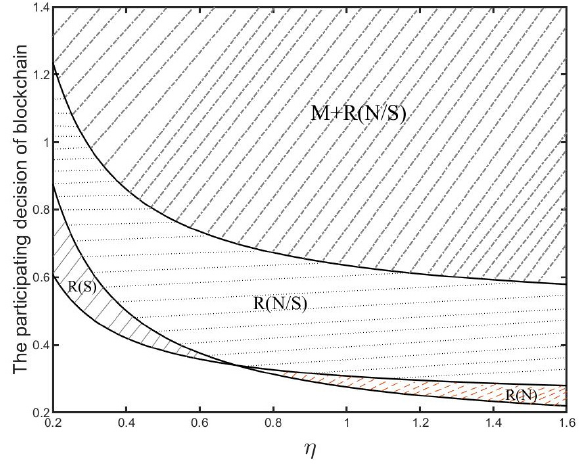
Figure 3. The supply chain members’ participating decision. ( α = 2.2, ε = 0.7, η = 0.9, σ =